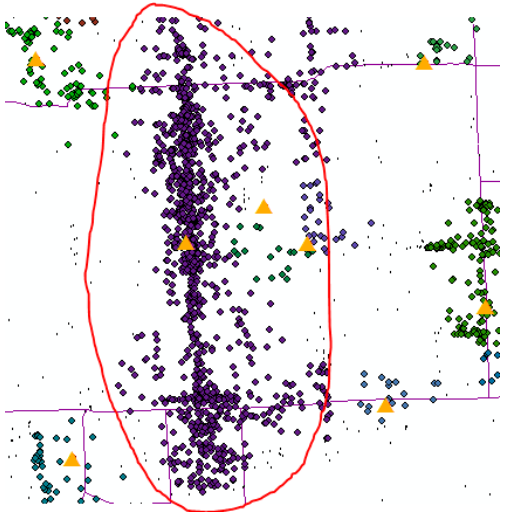
Figure 11. DBSCAN-based cluster distribution in Tiananmen Square and its surrounding area.